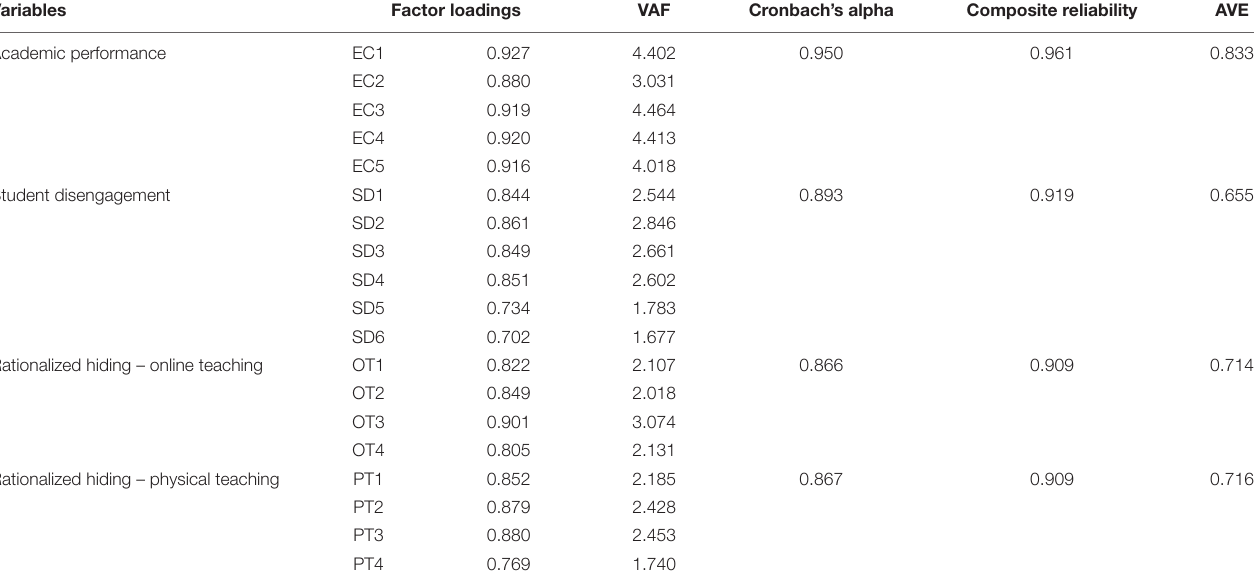
TABLE 2 | Factor loadings and reliabilities.